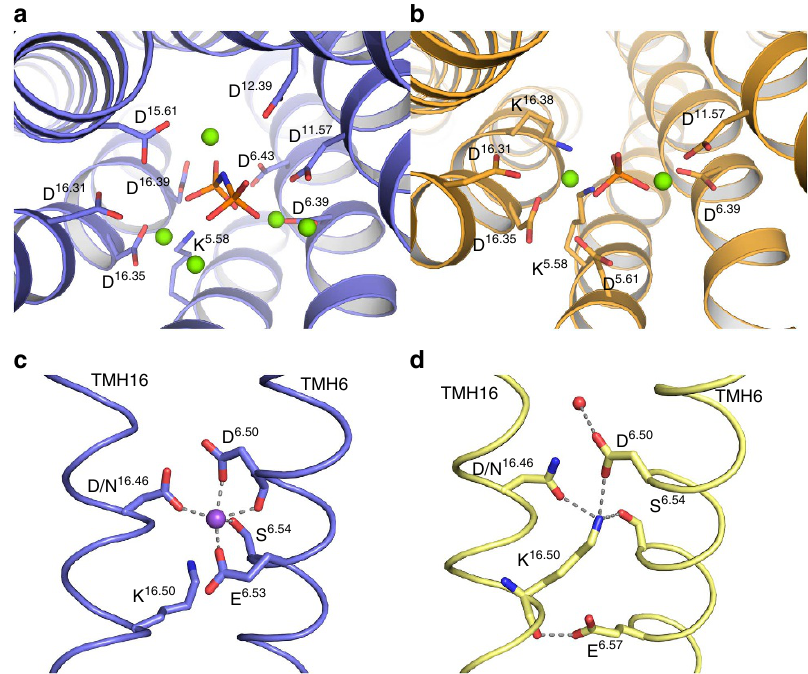
Figure 2 | Hydrolytic centre and ion gate of TmPPase and VrPPase. Key residues are labelled and hydrogen bonds shown as dashed lines. ( a ) The hydrolytic centre of TmPPase:IDP (blue in all figures) with bound Mg 2 þ (green), IDP (orange) and coordinating residues. ( b ) Hydrolytic centre of VrPPase:P i (gold) showing Mg 2 þ (green), P i (orange) and coordinating residues. ( c ) Ion gate region of TmPPase:IDP showing bound Na þ (purple) and its coordination (grey). TMH 6 and 16 are labelled. ( d ) Ion gate of VrPPase:IDP (yellow) showing the salt-bridge network (yellow) and coordinated waters (red). TMH 6 and 16 are